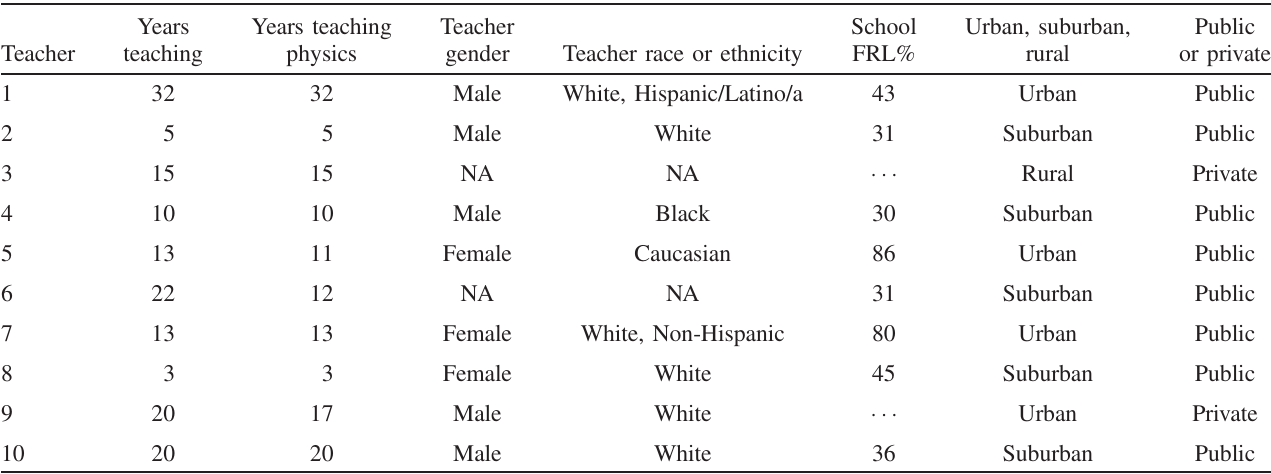
TABLE VI. Summary of teacher or school characteristics, Study 1. NA represents a response not self-reported by the teacher. Free or reduced lunch rate (FRL%) not available for private schools (denoted “…”